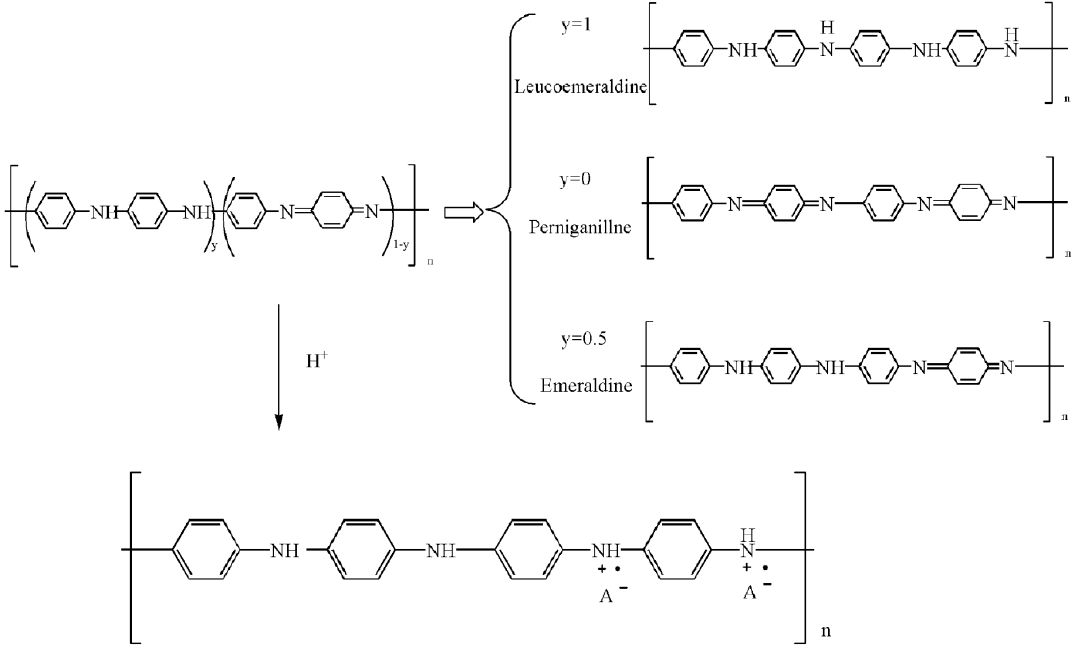
Figure 11. Scheme representation of redox status for PANI.